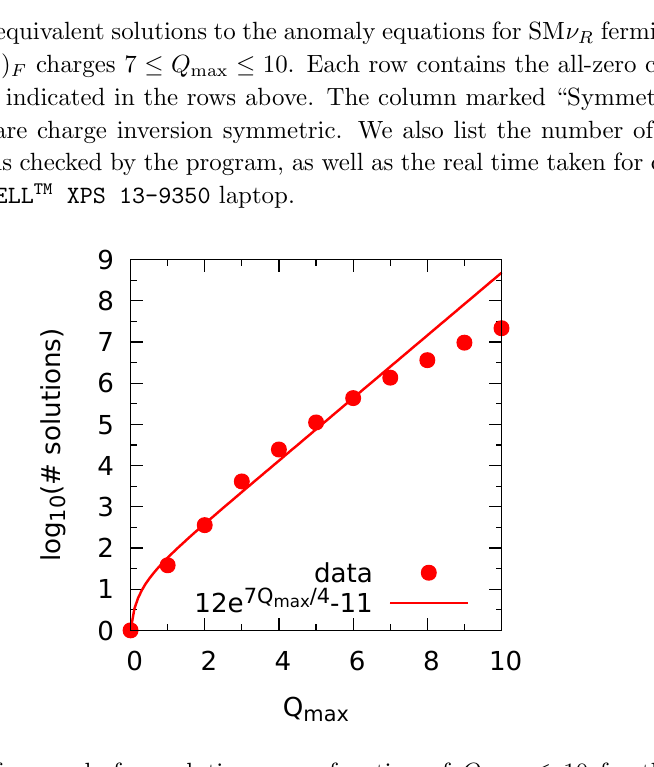
Figure 1 . Number of anomaly-free solutions as a function of Q max (cid:20) 10 for the SM (cid:23) R . For comparison, we show the \(cid:12)t-by-eye" 12 e 7 x= 4 (cid:0) 11 originally suggested [1] to (cid:12)t the growth of the number of solutions.